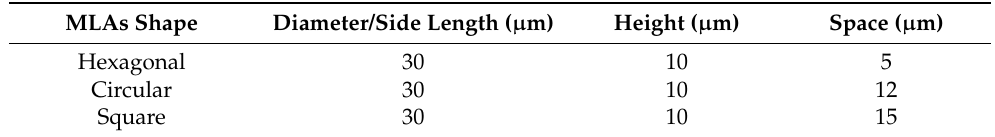
Figure 1. Design of MLAs masks with different arrangement shapes: ( A ) hexagonal combination arrangement, ( B ) circular combination arrangement, and ( C ) square combination arrangement. Table 1. Specific values for the MLAs.